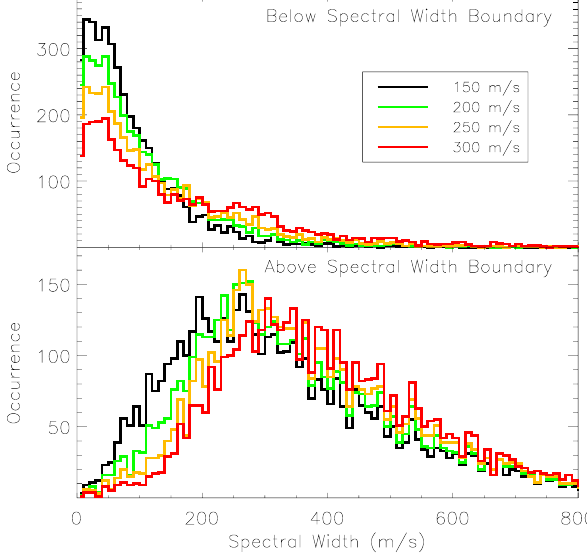
Fig. 14. The distribution of spectral width values below and above the spectral width boundary as determined by applying algorithm 2 to one year of data (from 1998) from beam 8 of the Halley Su- perDARN radar. Only cusp-region spectral widths (from 08:00– 12:00MLT), from within 10 range gates of the estimated boundary position, are shown. The four different lines represent the results from using four different spectral width threshold values (150, 200, 250, and 300 m/s) to identify the boundary.